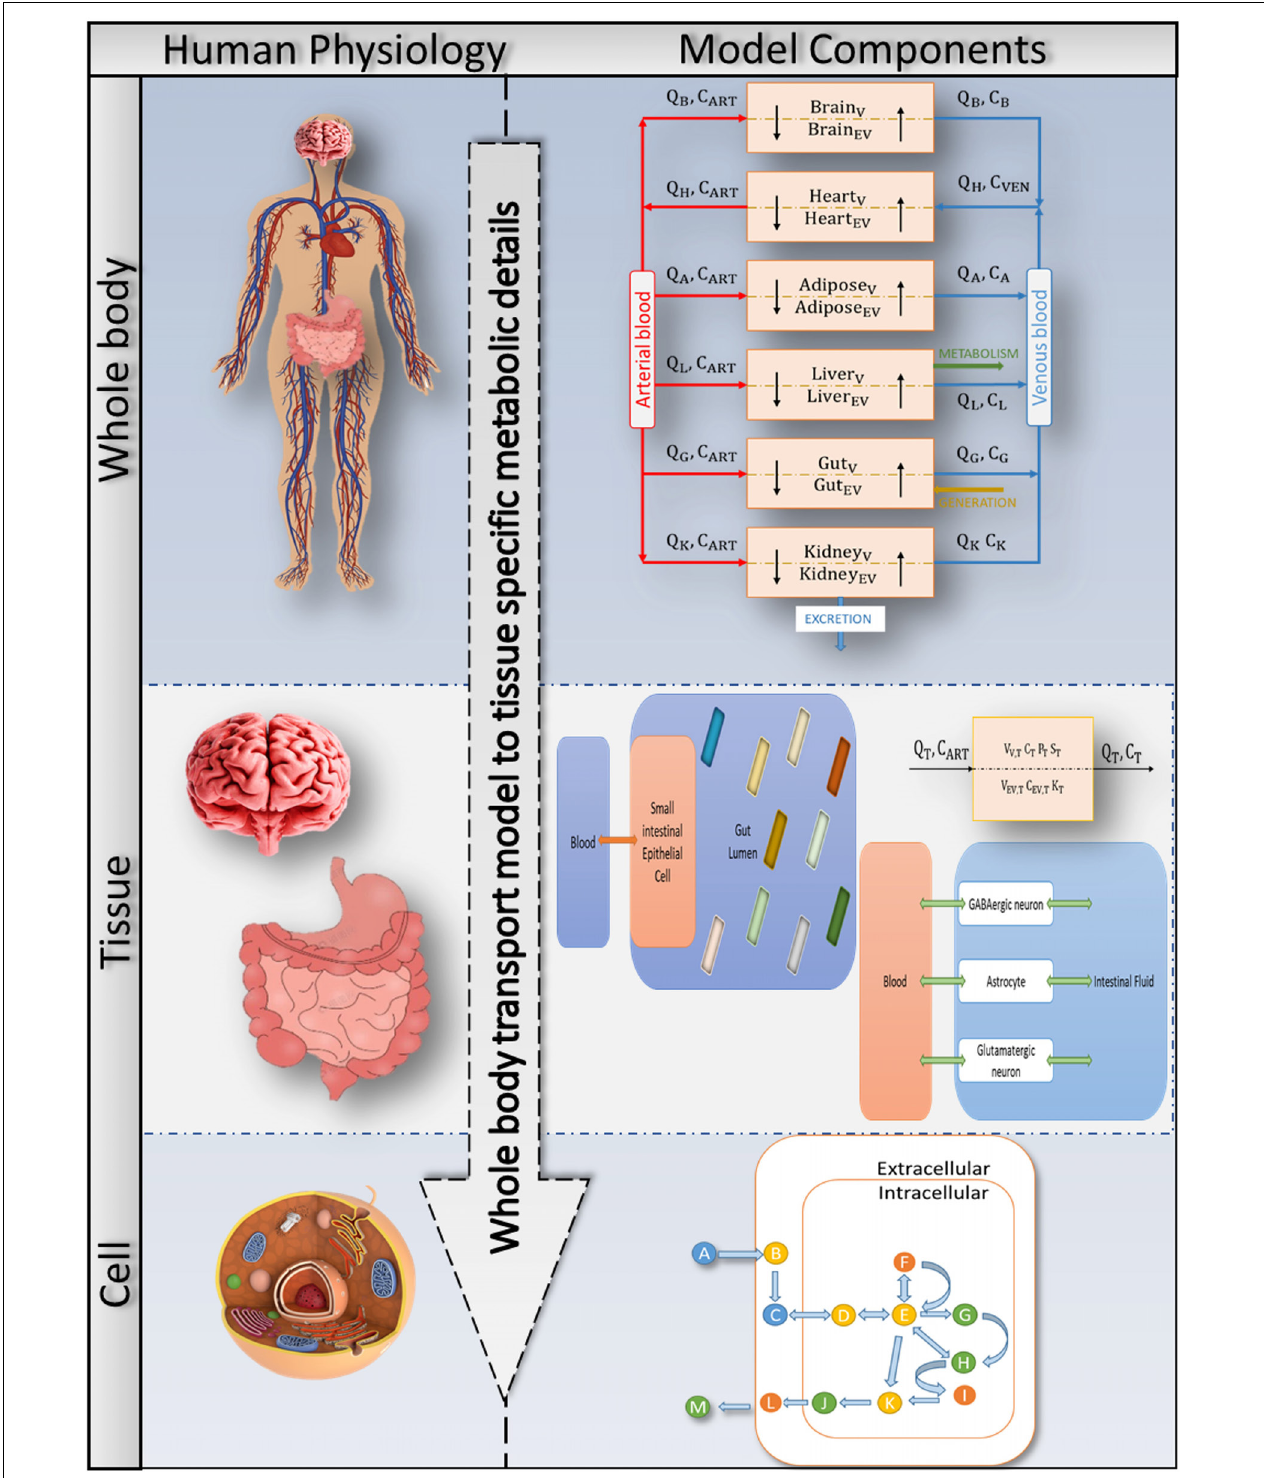
FIGURE 2 | Bringing together whole-body physiology and model components: each tissue of interest is modelled as a two-compartment, permeability-limited, well-stirred tank with vascular and extravascular compartments. The circulatory system connects the various compartments. The cellular biochemistry in the interstitial (extracellular) and intracellular (cytosol, mitochondria, peroxisome, and so on) areas is described using genome-specific COBRA models. A combined PBPK-GSMN model connects tissue-specific metabolic details into a comprehensive representation of a whole-body physiologically based pharmacokinetic (PBPK) model via the shared exchange toxins